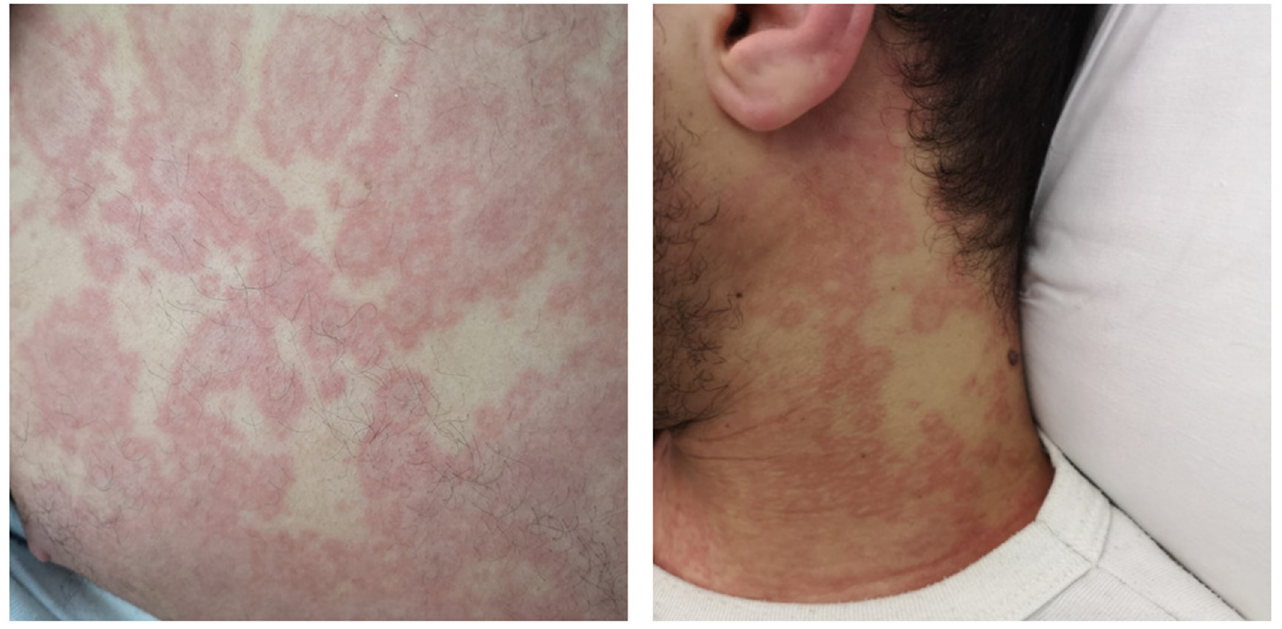
Figure 1. Annular lesions of the trunk and neck.